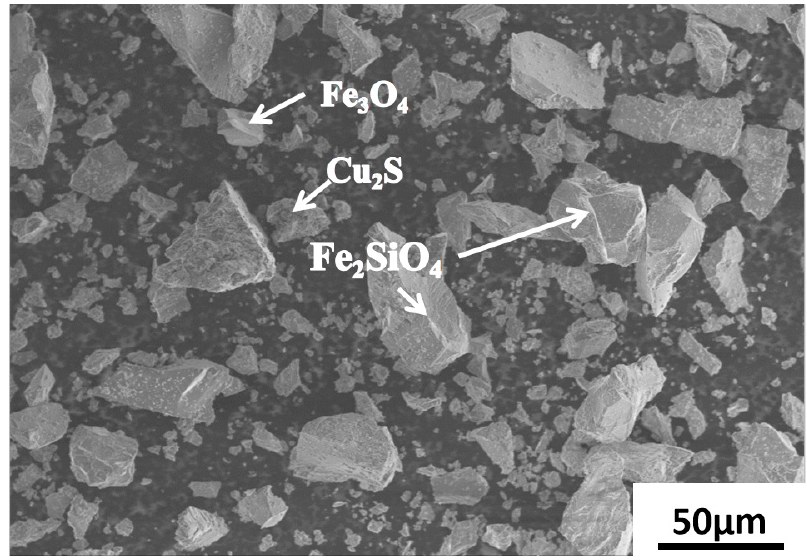
Figure 2. SEM analysis of copper slag.